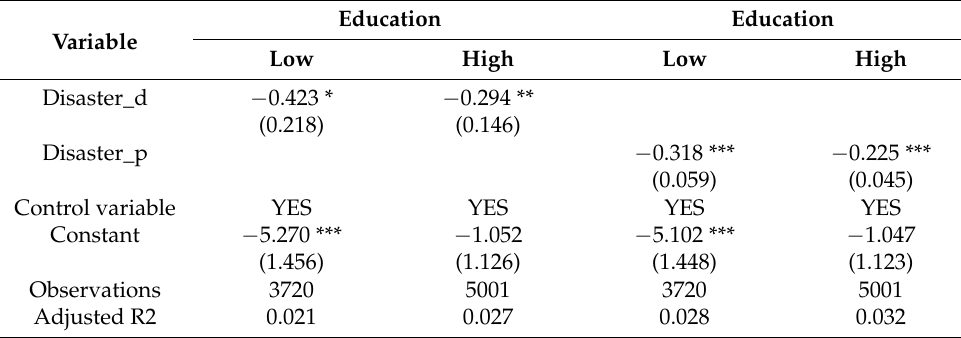
Table 7. Heterogeneous effects of natural disaster by education level.